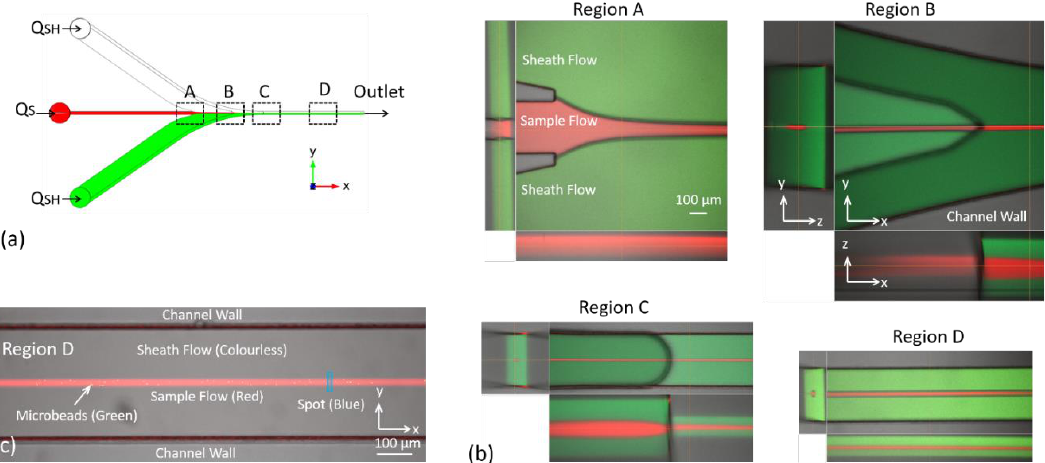
Figure 5. Flow configuration in key regions: ( a ) the key regions in the design and ( b ) the confocal images where the sample flow was red and sheath flow was green. The images were obtained under the condition of Q S = 60 μL/min, Q SH = 7.2 mL/min, and V S = 5.2 m/s. ( c ) The red sample flow contained 3 μm green microbeads, and the sheath flow was distilled water with no fluorescein.